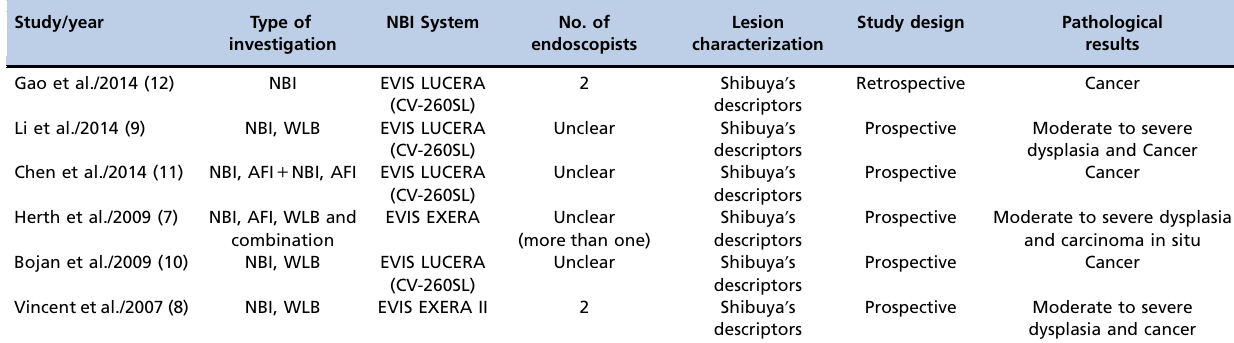
Table 1 - Characteristics of the studies included in this meta-analysis (continued)